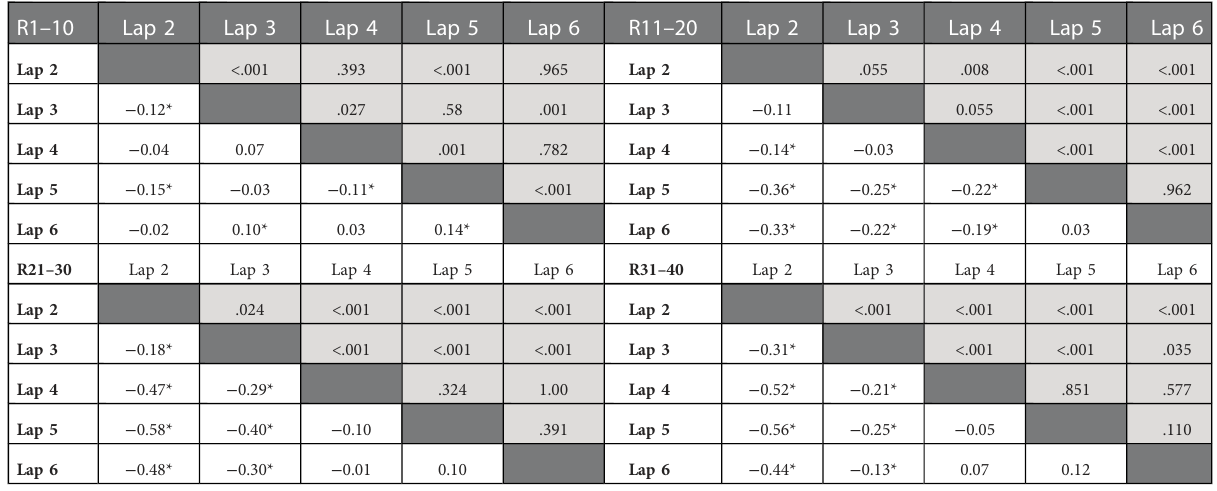
TABLE 2 Differences in average speed [m/s] between laps (white cells) with corresponding p -values (grey cells) for the different performance groups in a 21.8 km mass-start competition in cross-country